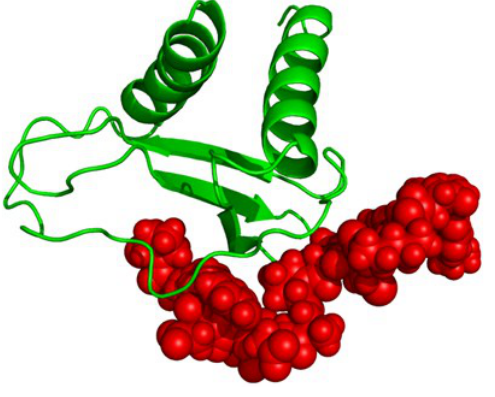
Figure 2. The CXCL10 (in green cartoon) is predicted to interact with a peptide (in red